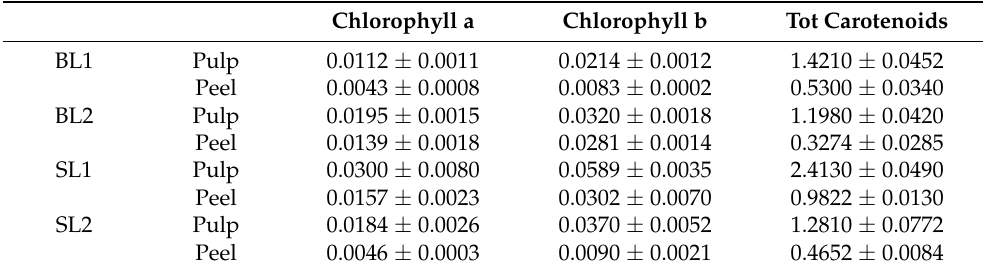
Table 4. Chlorophyll a, chlorophyll b, and total carotenoid concentrations by spectrophotometric analysis (mg/g of fresh sample ±